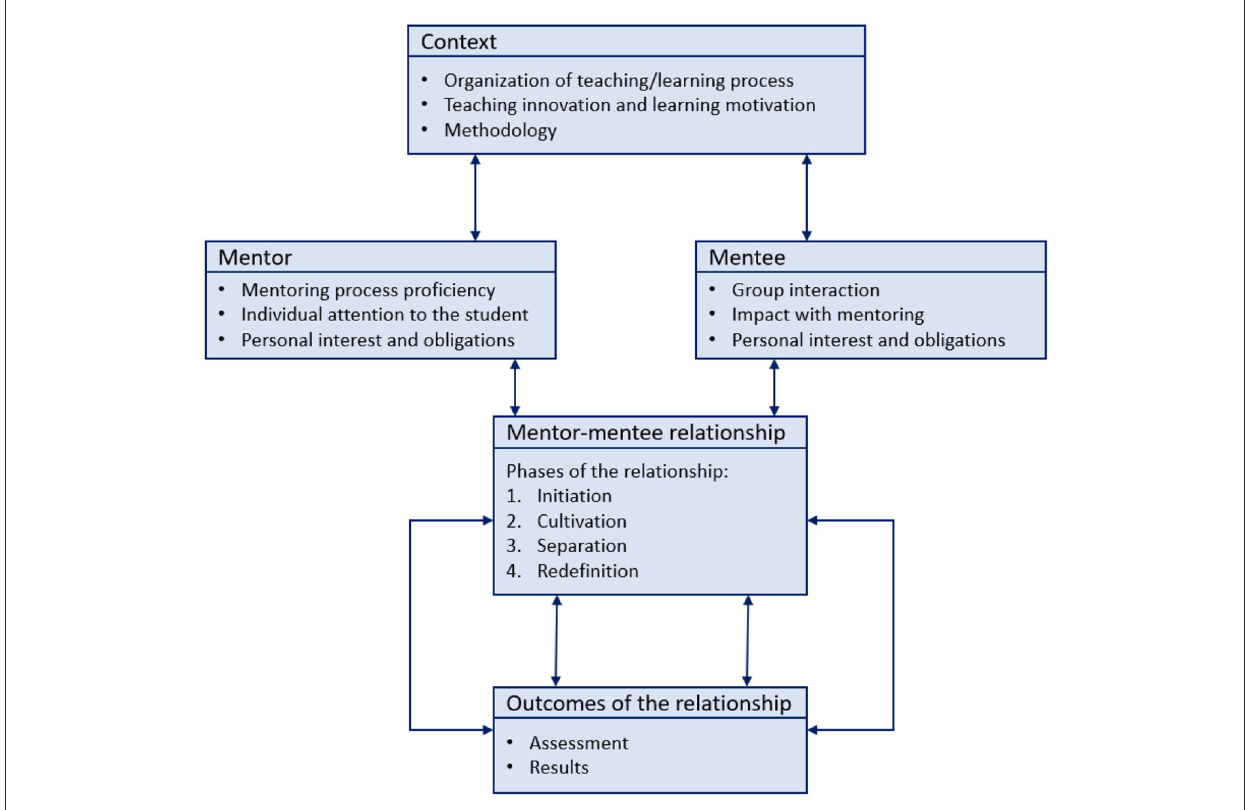
FIGURE1 Mentoring process framework at UFV.